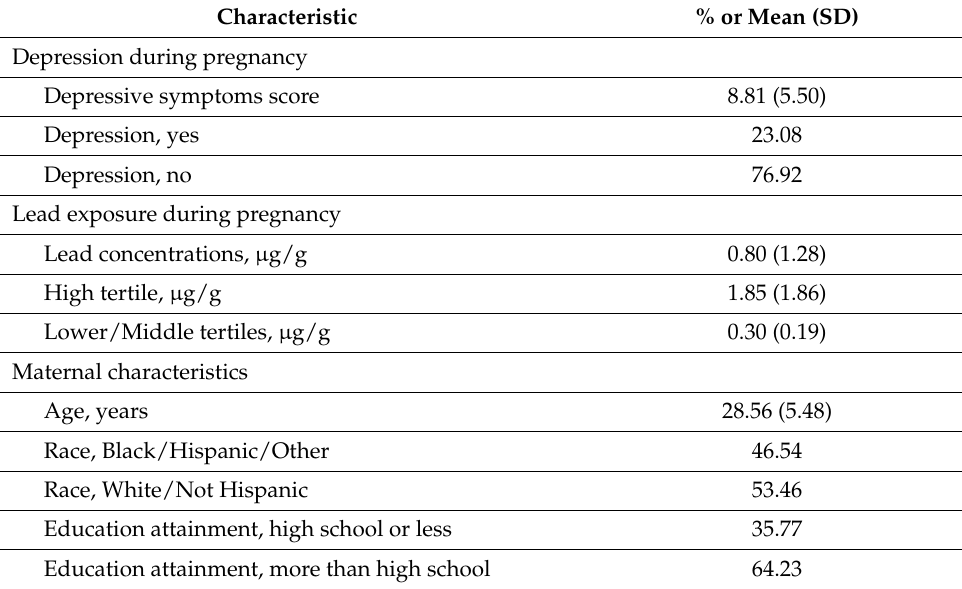
Table 1. Participant characteristics ( n =